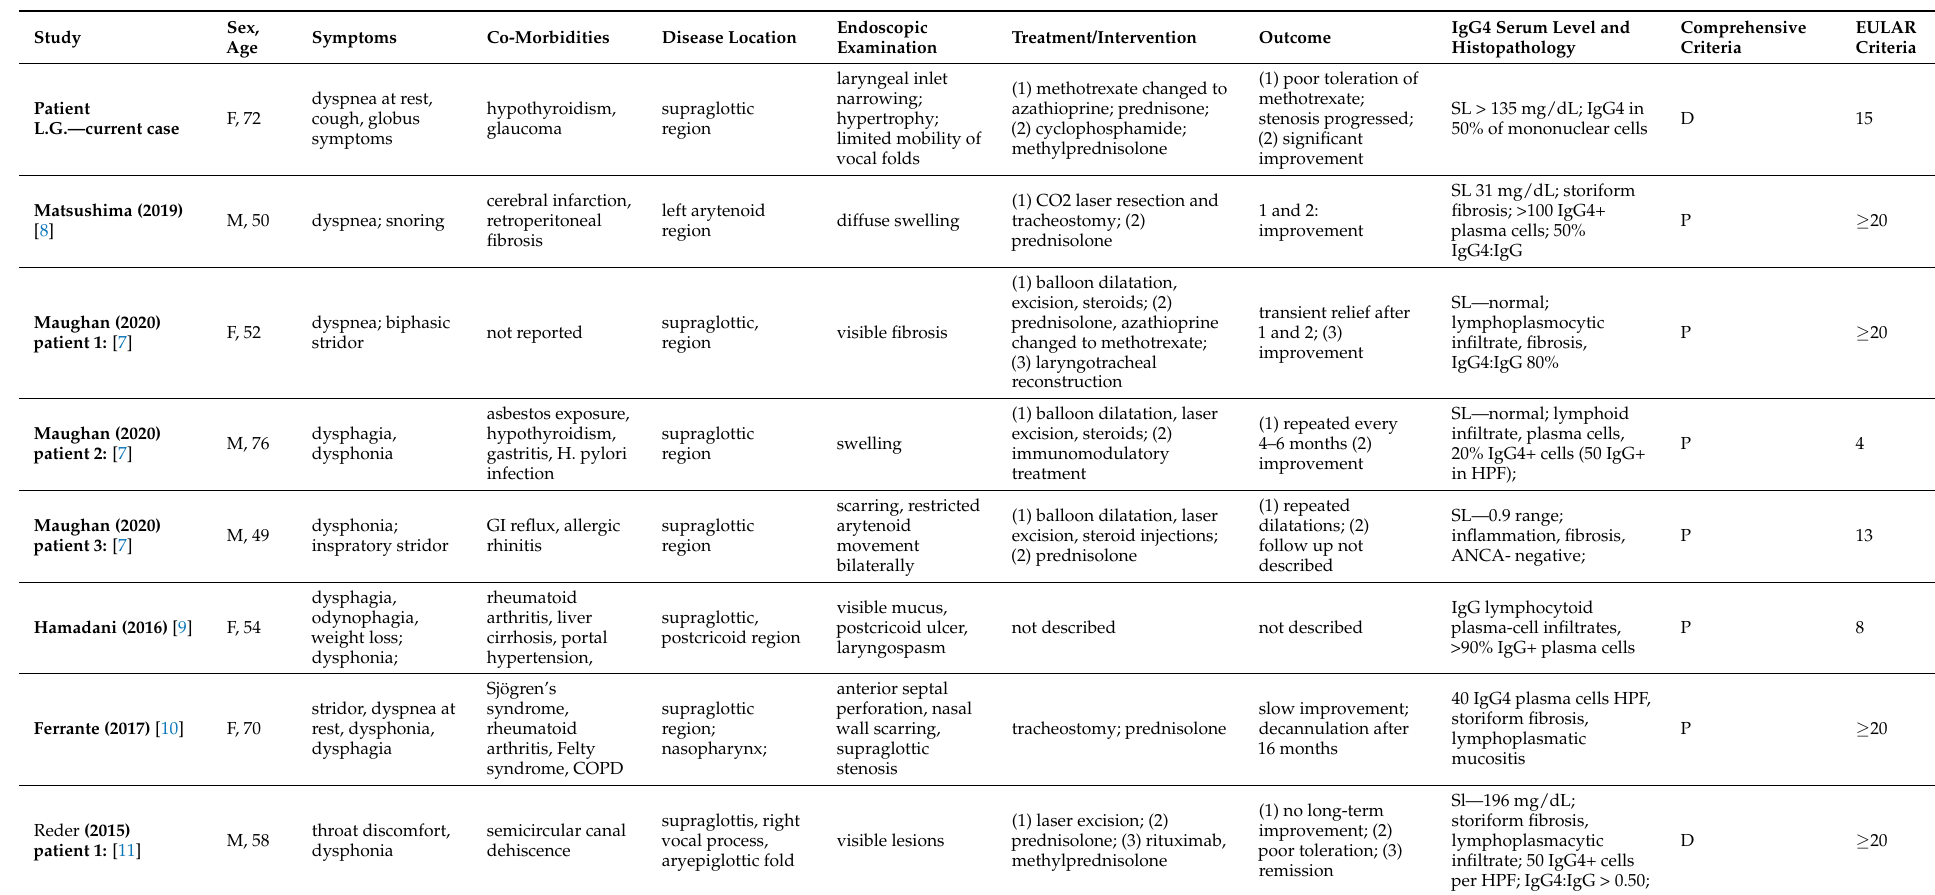
Table 1. Overview of selected studies. Abbreviations: F—female and M—male; Comprehensive criteria diagnosis: D—definite diagnosis and P—probable